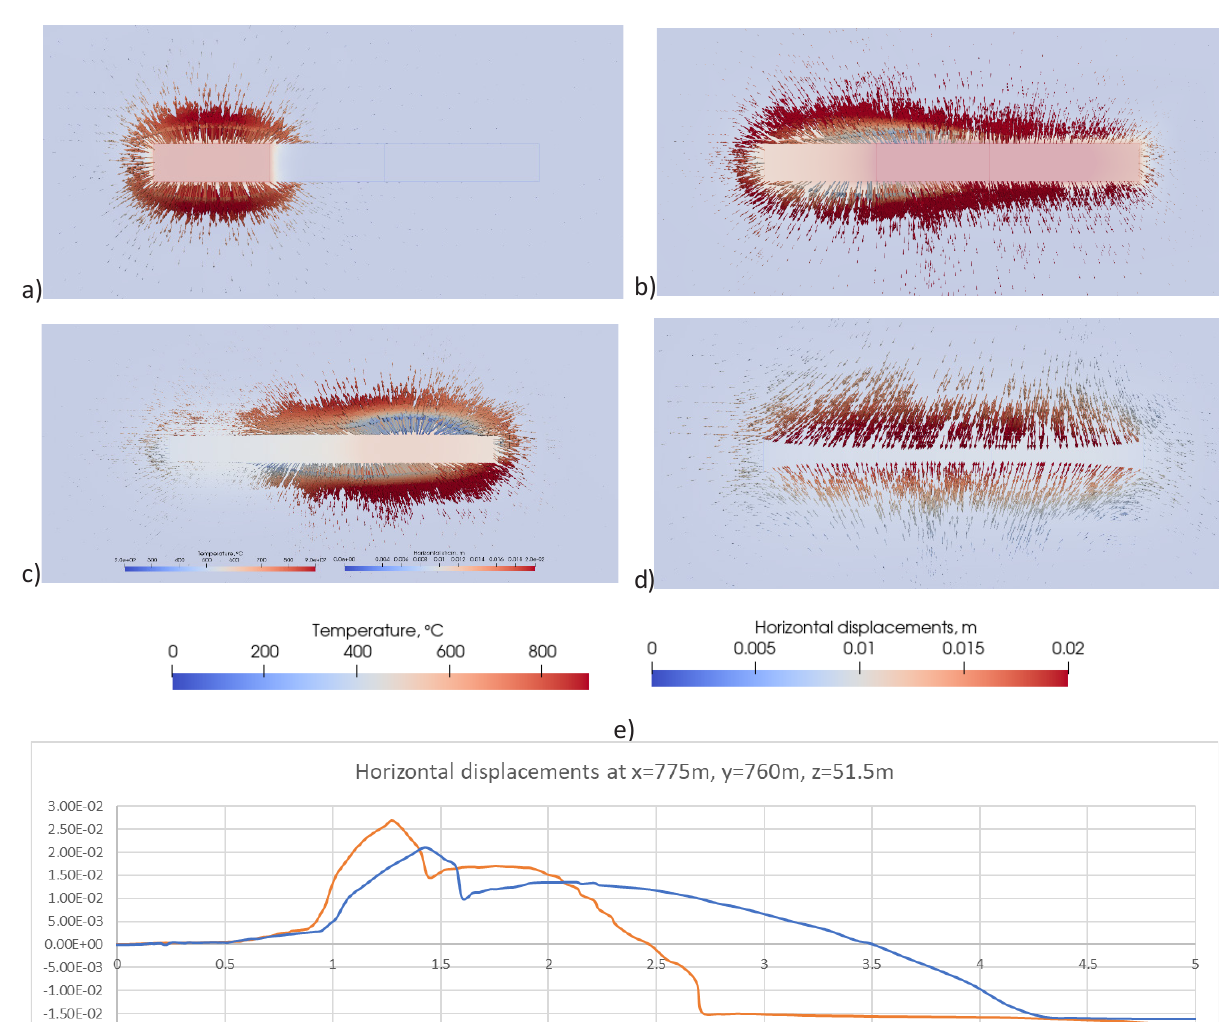
Figure 11: Vector field of horizontal displacements (m): a-d) on the background of the temperature in cross-section z = 51.5: a) 1 month, b)